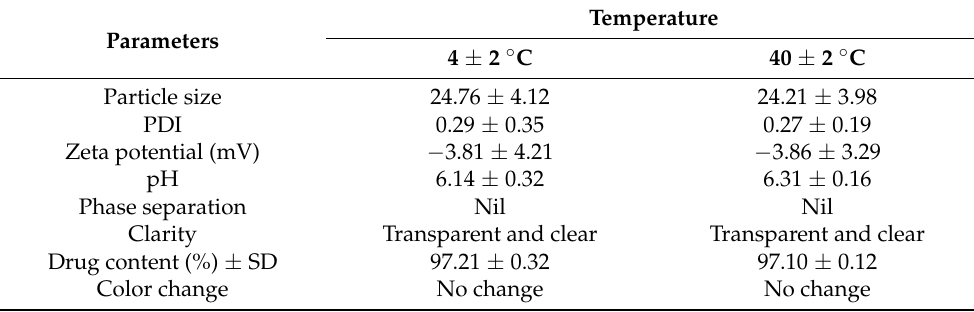
Table 7. Storage stability of methotrexate nanoemulsion gel formulation (FNEG6) at refrigerated and accelerated temperatures for 60 days.